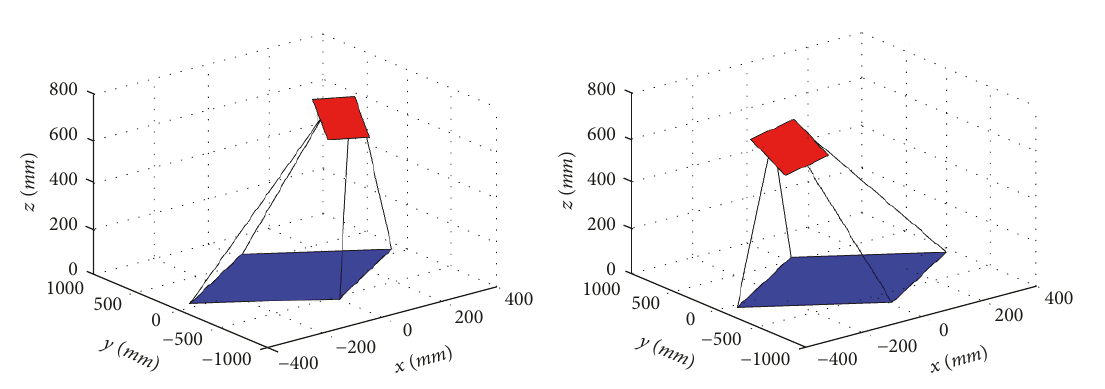
Figure 4: Different configurations for inverse position.